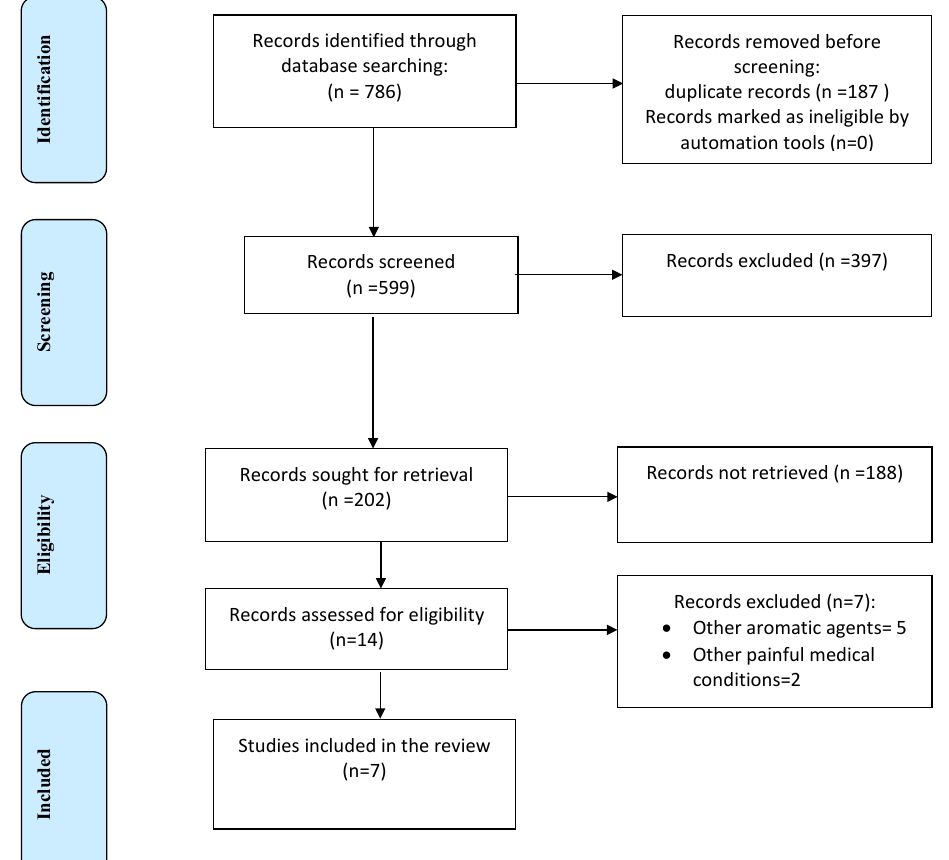
Figure 1. PRISMA Flow